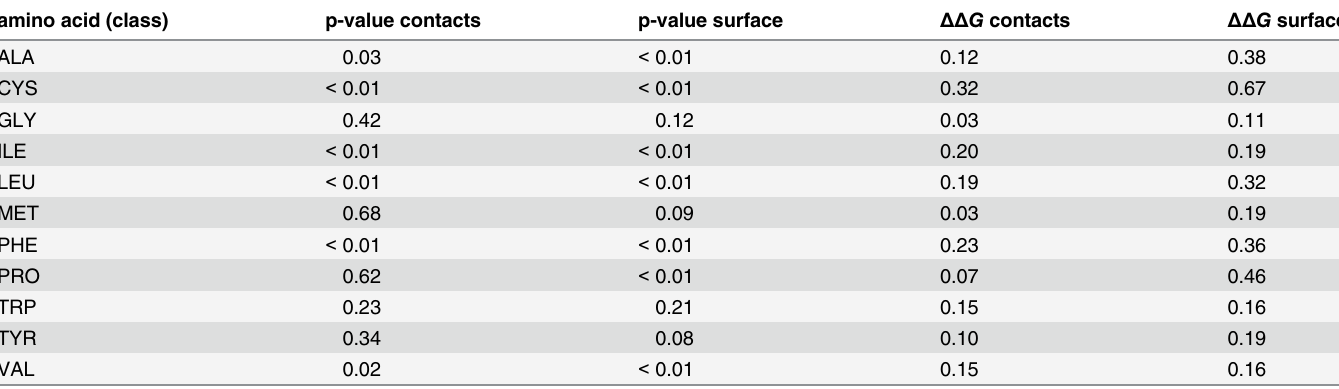
Table 4. Significance of hydrophobic temperature